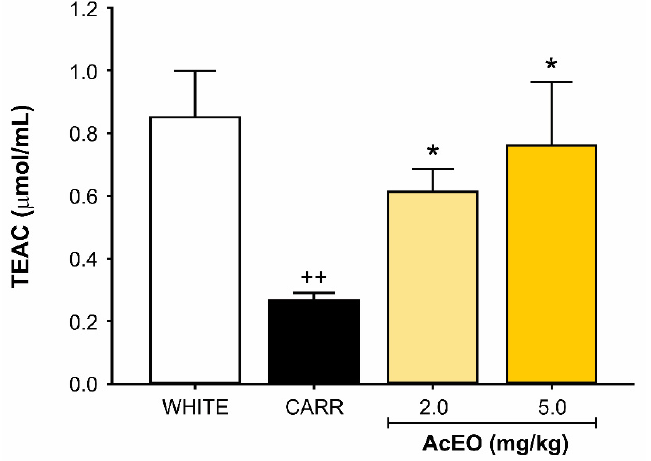
Figure 3. Effect of Aniba canelilla essential oil (AcEO; 2.0 and 5.0 mg/kg; ip.) on the total antioxidant capacity of the peritoneal fluid of rats submitted to carrageenan (CARR)-induced (0.3 mg/kg) peritonitis. Data expressed as mean ± SEM ( n = 6/group). ++ p < 0.01 vs. white group; * p < 0.05 vs. CARR group. Kruskal–Wallis followed by Dunn’s test.